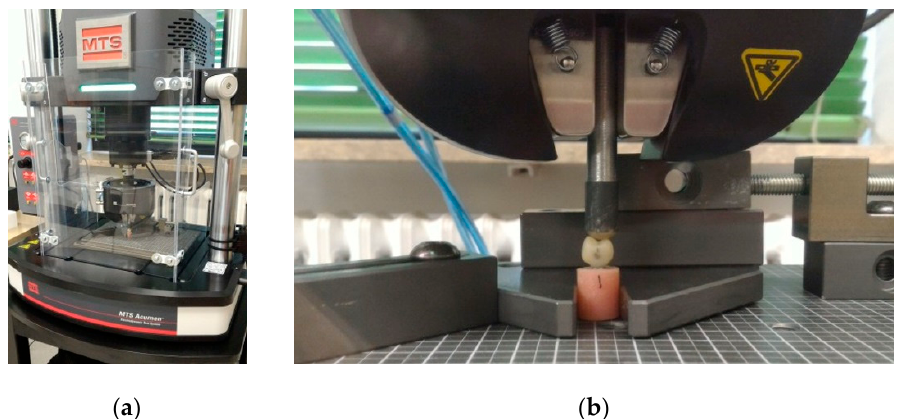
Figure 6. Testing apparatus: ( a ) MTS Acumen 3 Electrodynamic Test System and ( b ) magnification of the grips system and the loading punch.